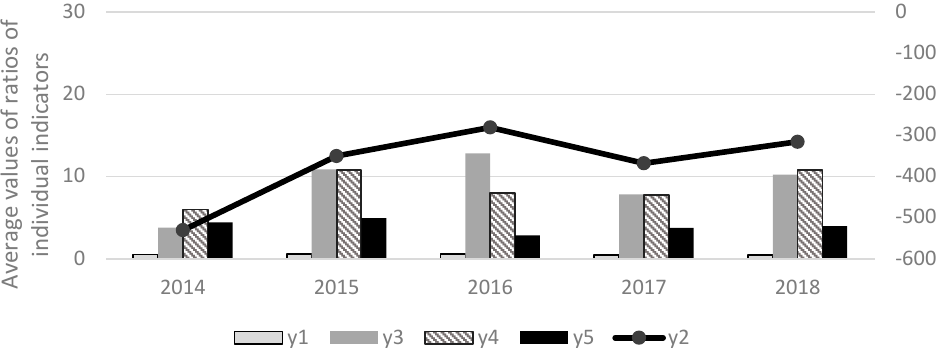
Figure 9. Average values of IN05 index.